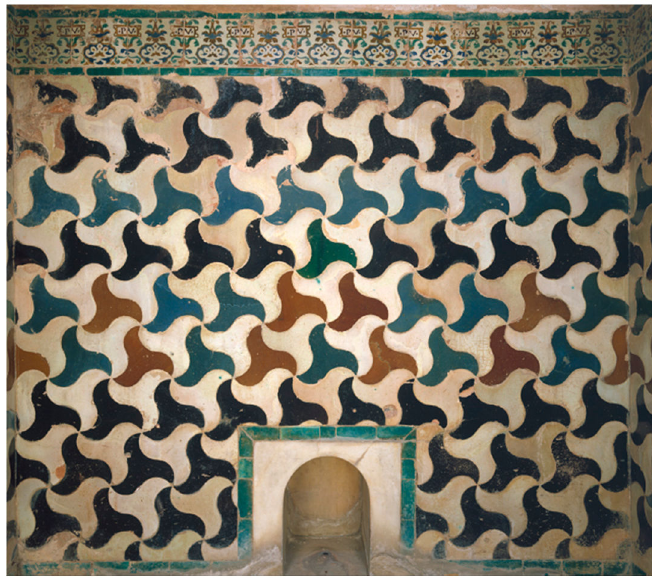
Figure 12. Detail of alicatados in the Comares Baths, built in the 14th century, although featuring some ceramic pieces from the 16th century which are clearly visible in the arista tiles from this period bearing the initials of Plus Ultra. © Mar í a Elena D í ez Jorge,